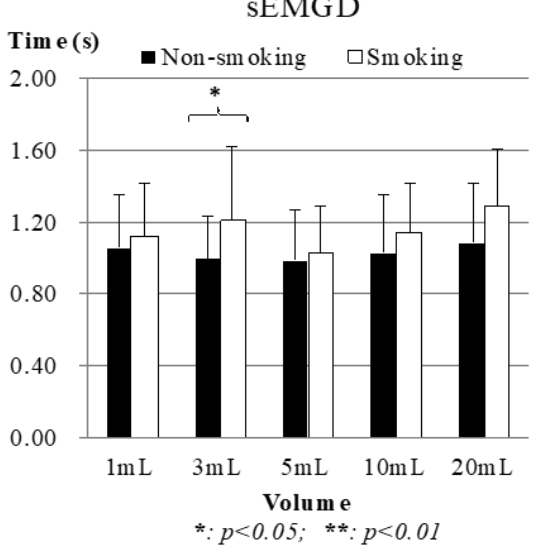
Figure 7. Average results of surface electromyography duration (sEMGD). Piecemeal swallowing cases were excluded.